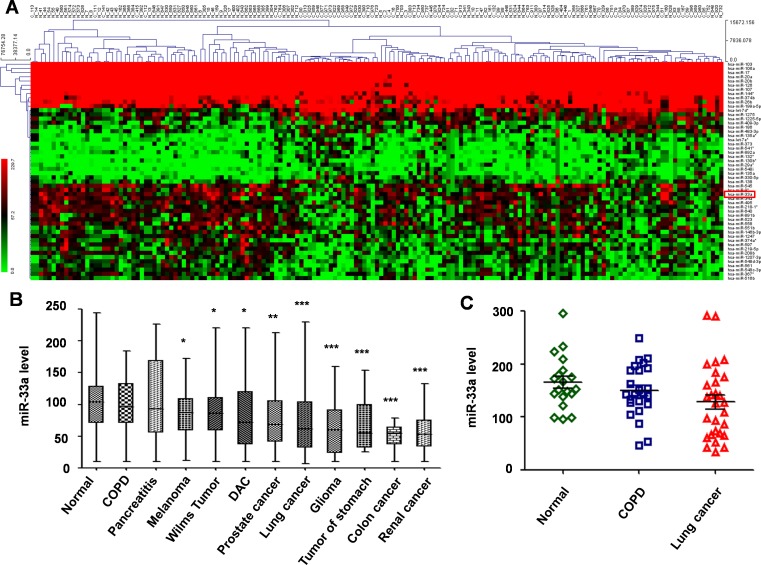
Analysis of miR-33a expression from GEO datasets.A, Data from the GEO dataset (GSE59153) was clustered using MEV 4.7.1 software. B, Relative expression levels of miR-33a in different cancers vs. normal controls from the GEO dataset (GSE59153). C, Relative expression levels of miR-33a in NSCLC and adjacent normal tissues from patients with cancerous and non-cancerous lung diseases from the GEO dataset (GSE24709).